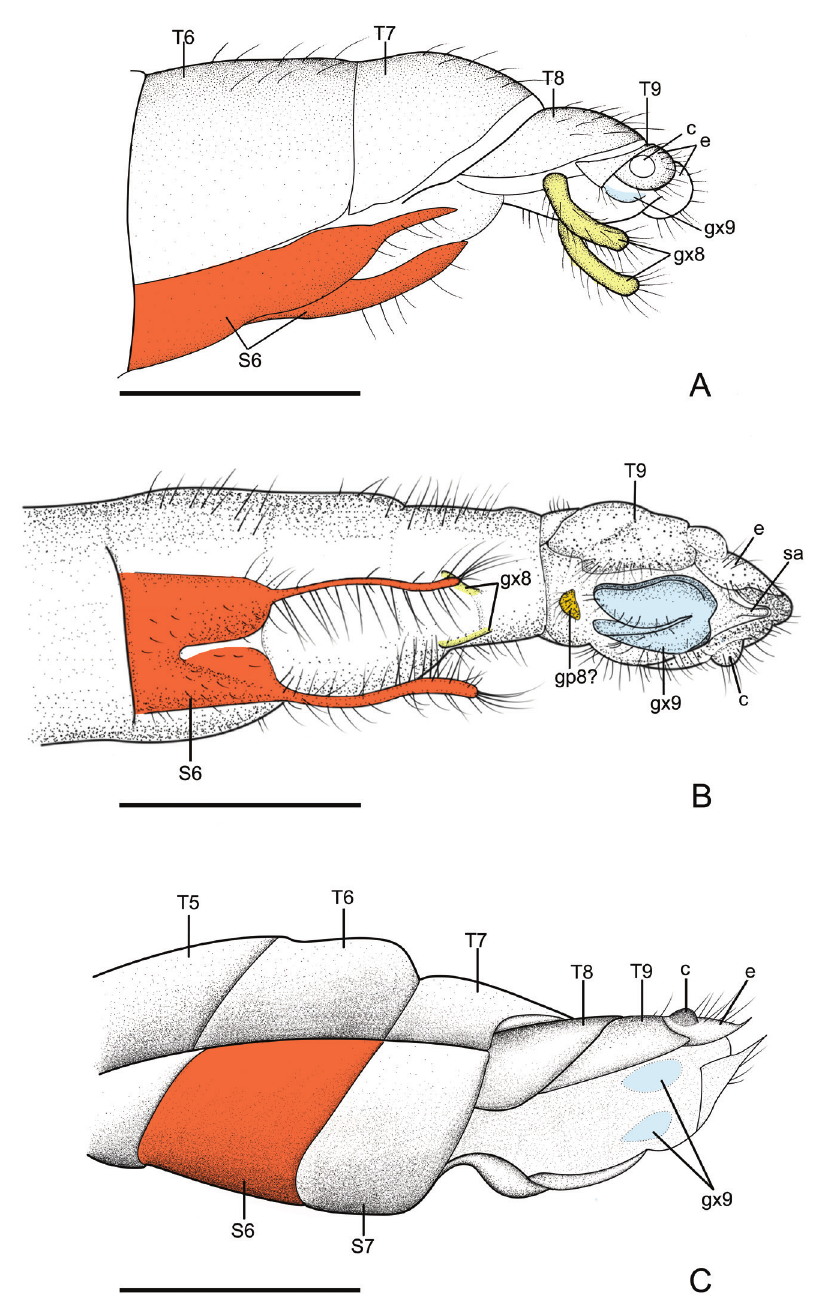
Figure 7. Female genitalia of babinskaiid species from the Burmese amber. A Female genitalia of Pseudo- babinskaia martinsnetoi (Lu, Zhang & Liu) B Female genitalia of Electrobabinskaia burmana Lu, Zhang & Liu C Female genitalia of Parababinskaia makarkini sp. n. Abbreviations: T: tergum; S: sternum; c: callus cercus; e: ectoproct; gp: gonapophysis; gx: gonocoxite; sa: subanale. Scale bars: 1.0